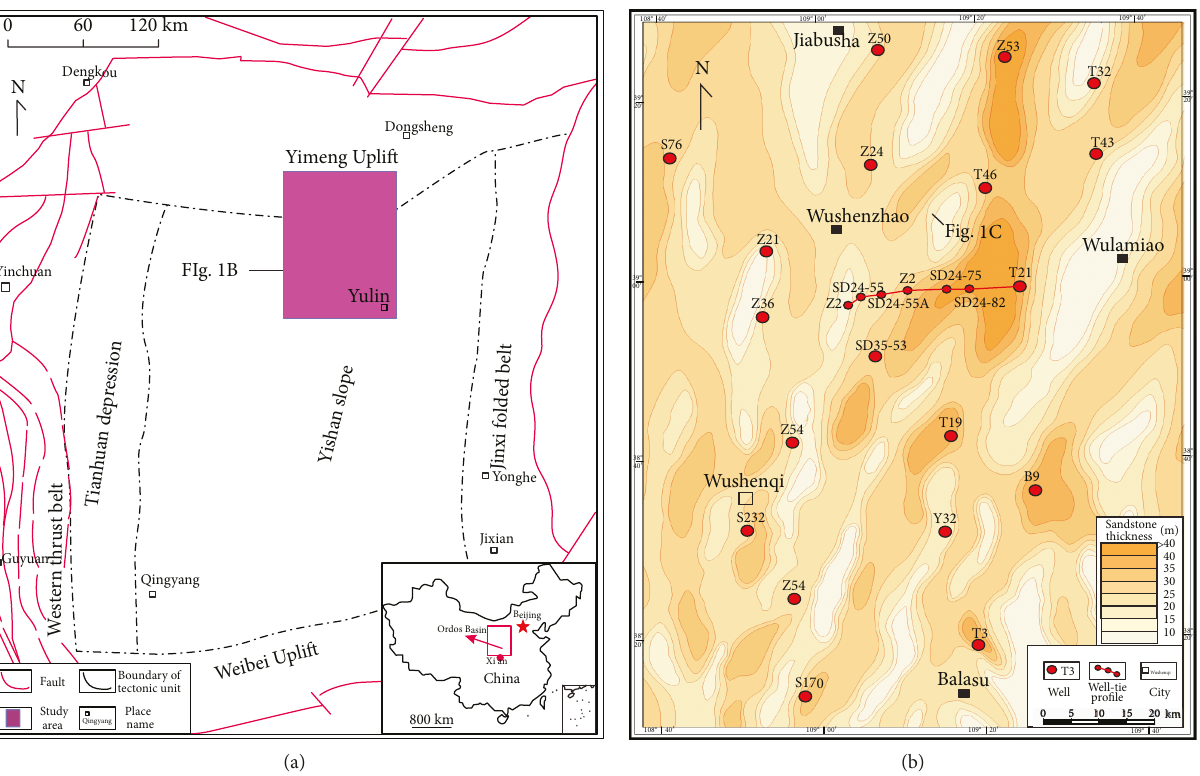
Figure 1: (a) Regional map of the Ordos Basin and the location of the eastern part of the Sulige gas fi eld. (b) Detailed map and sandstone thickness distribution of the eastern part of the Sulige gas fi eld with the locations of the wells referred to in this